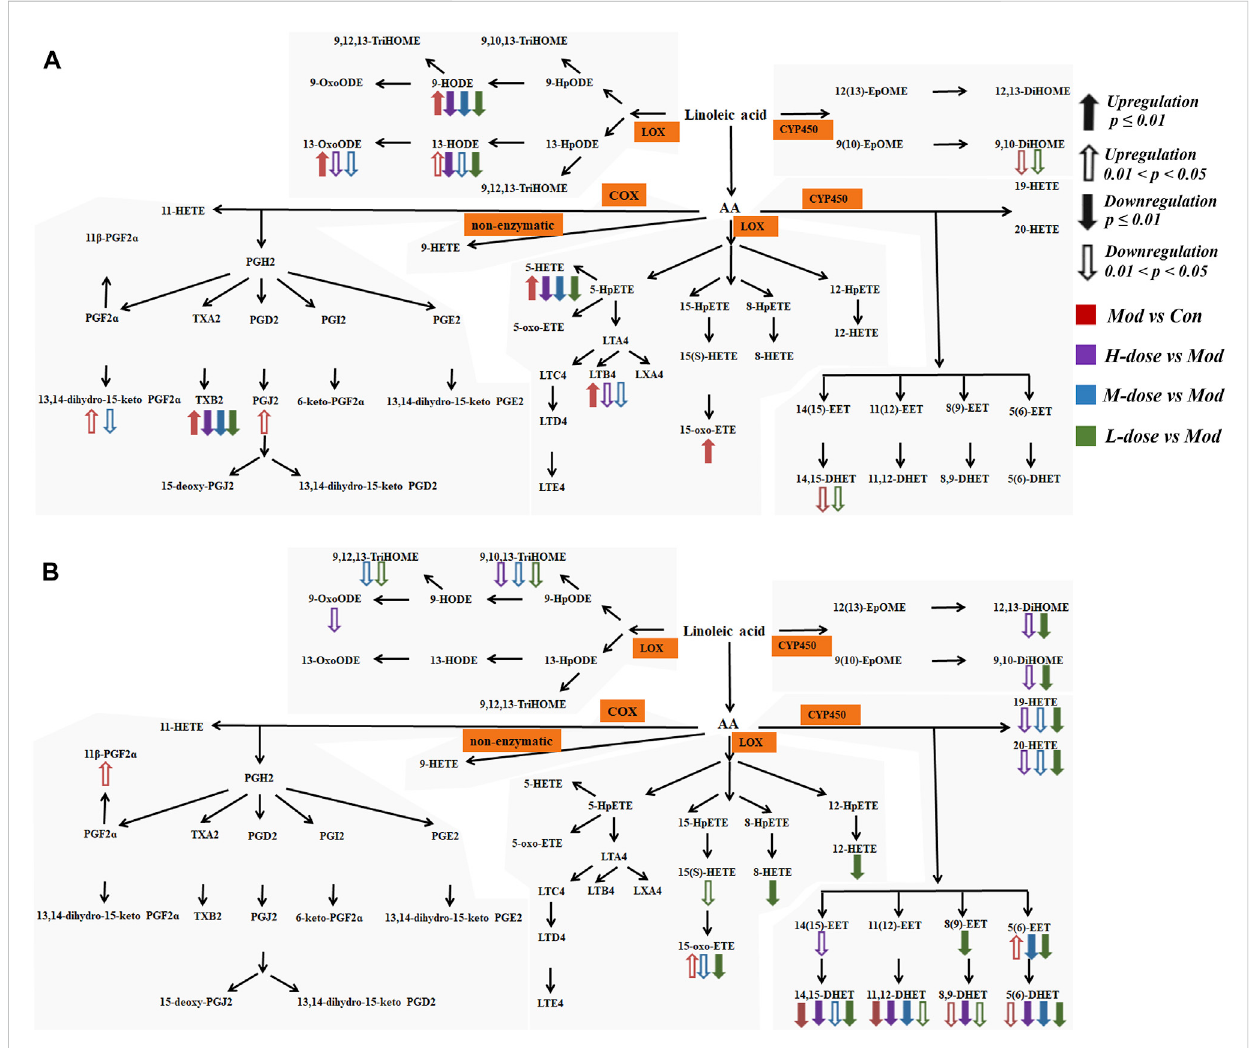
LMs detected in biological samples with their metabolism pathway and variations among different groups. (A) LMs in lung tissue. (B) LMs in